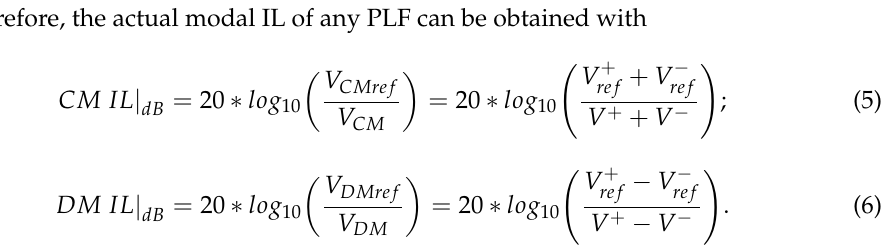
Figure 6. PLF connected between the equivalent circuit of a EUT and the equivalent circuit of a LISN according to CISPR 16.